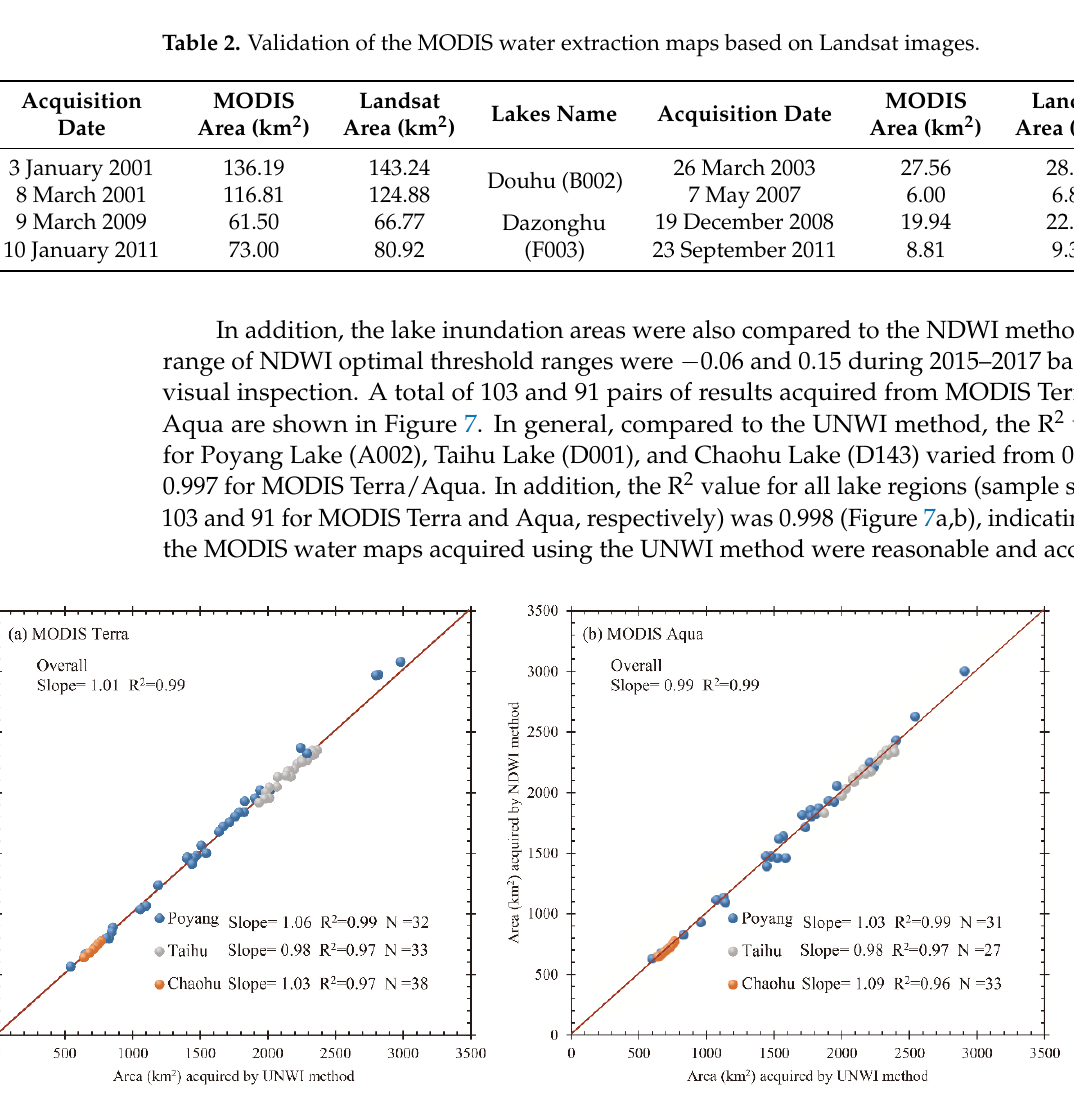
Figure 7. Comparisons of UNWI and NDWI results from MODIS ( a ) Terra and ( b ) Aqua during 2015–2017. The red line represents the 1:1 line.